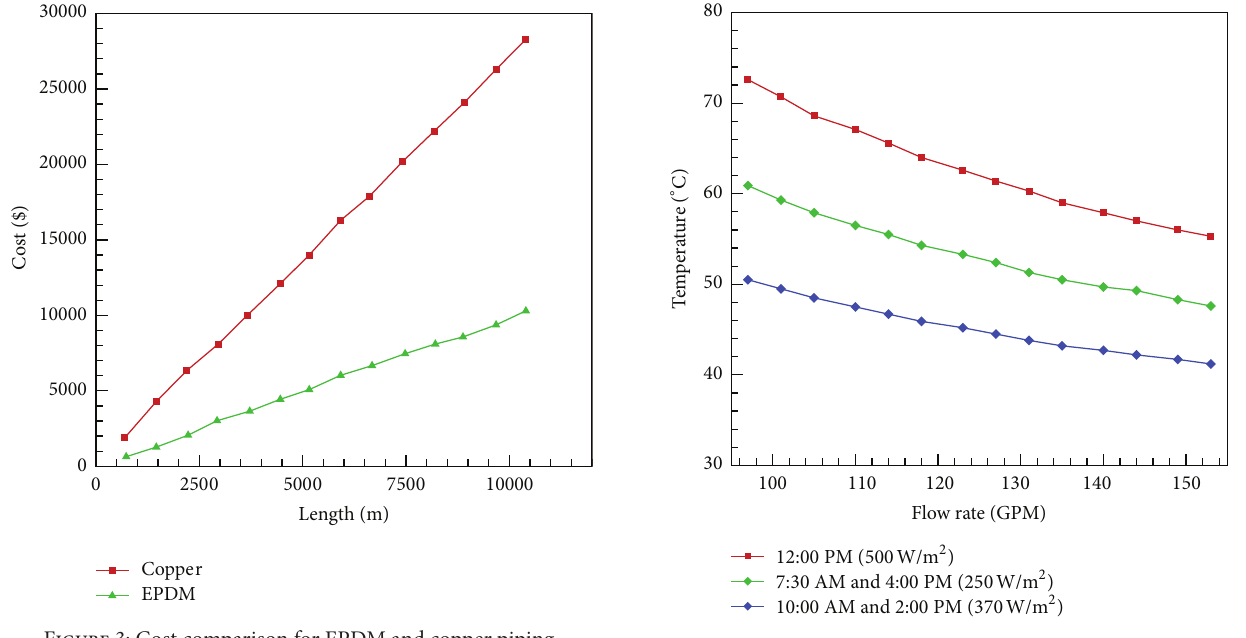
Figure 5: Performance analysis for the month of